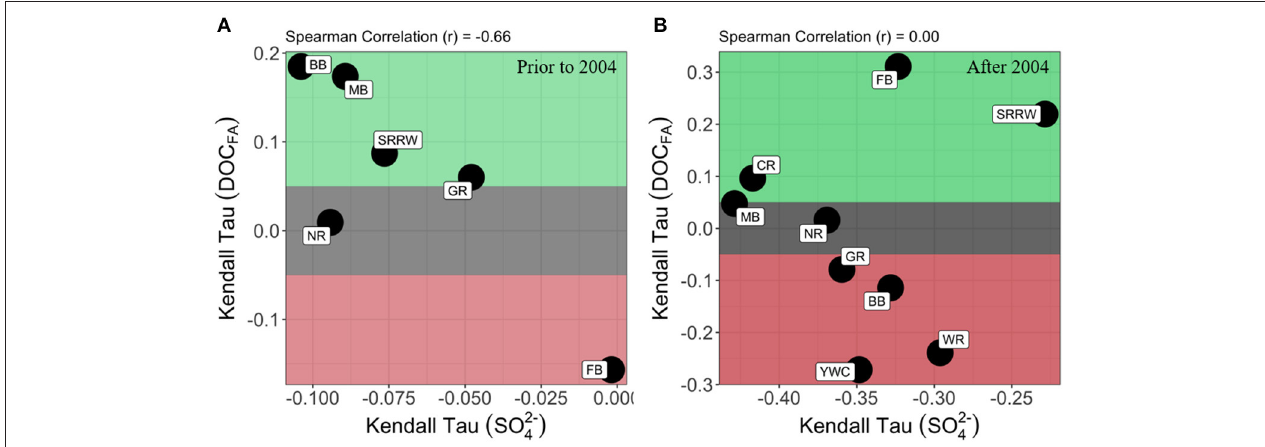
FIGURE 6 | Relationship between trends in flow-adjusted dissolved organic carbon concentration (DOC FA ) and trends in sulfate wet deposition (SO − 2 4 ) for Northeast U.S. forested headwater catchments: (A) prior to 2004 ( n = 6) and (B) after 2004 ( n = 9). Shading highlights those regions of the plot where DOC FA exhibits statistically-significant positive trends (tau > 0.05; green), negative trends (tau < − 0.05; red), or no significant trend (0.05 > tau > − 0.05;